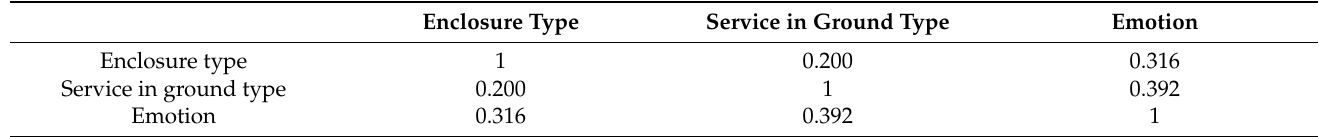
Table 3. Relevance of enclosure type, service in ground type and emotion.